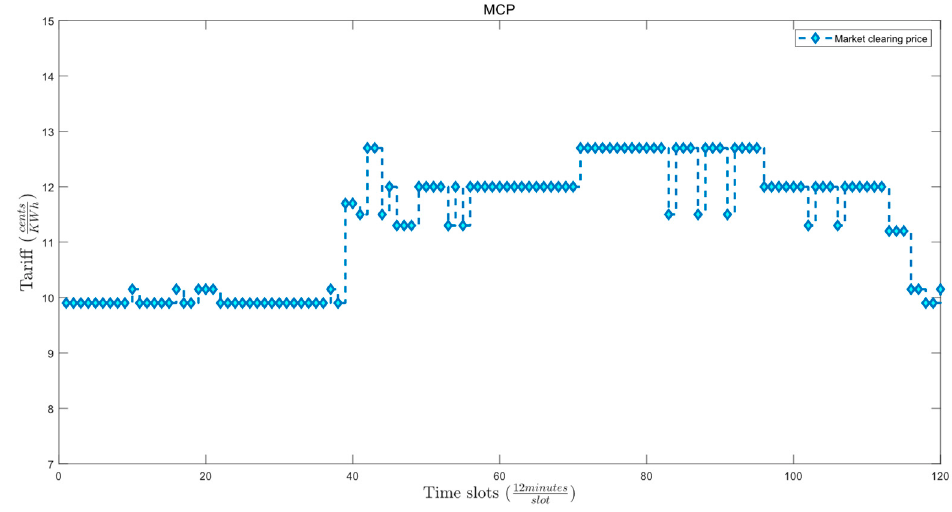
Figure 13. MCP determined for energy trading in LETM.